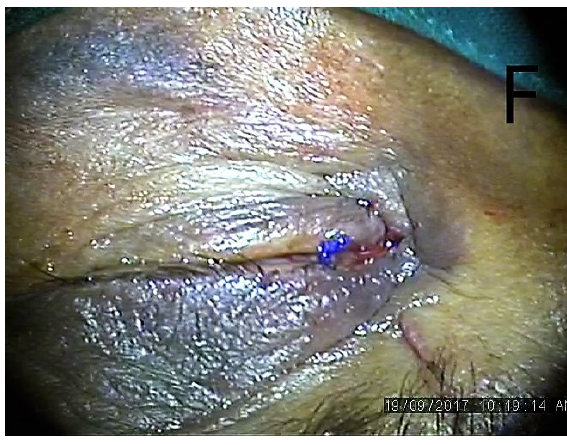
Figure 6: Prolene suture left in place as